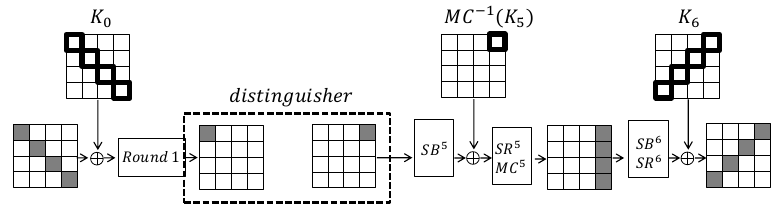
Figure 6: TweAES : 6-Round Key Recovery in Impossible Differential